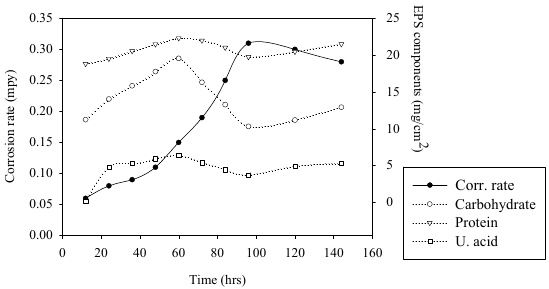
replenishingTime Figure 4. Corelation between corrosion rate (mpy) and EPS com- Fig. 4 Corelation between corrosion rate (mpy) and EPS components (carb., protein and U.acid) ponents (carb., protein and U.acid) of 304L with bacteria of 304L with bacteria during immersion tests without media during immersion tests without media